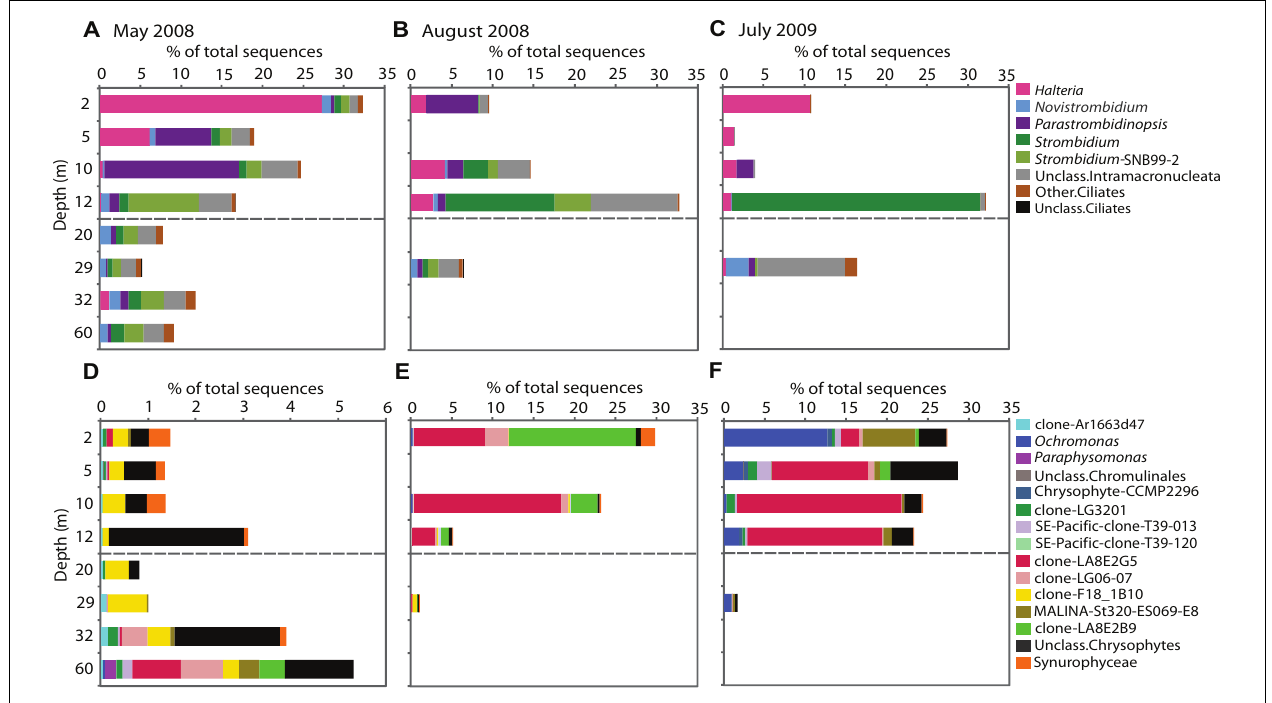
FIGURE 5 | Sequences of genera showing seasonal changes within Lake A in May 2008,August 2008 and July 2009. The bar graphs represent the ciliates (A–C) and chrysophyte genera (D–F) . Mixolimnion depths are above